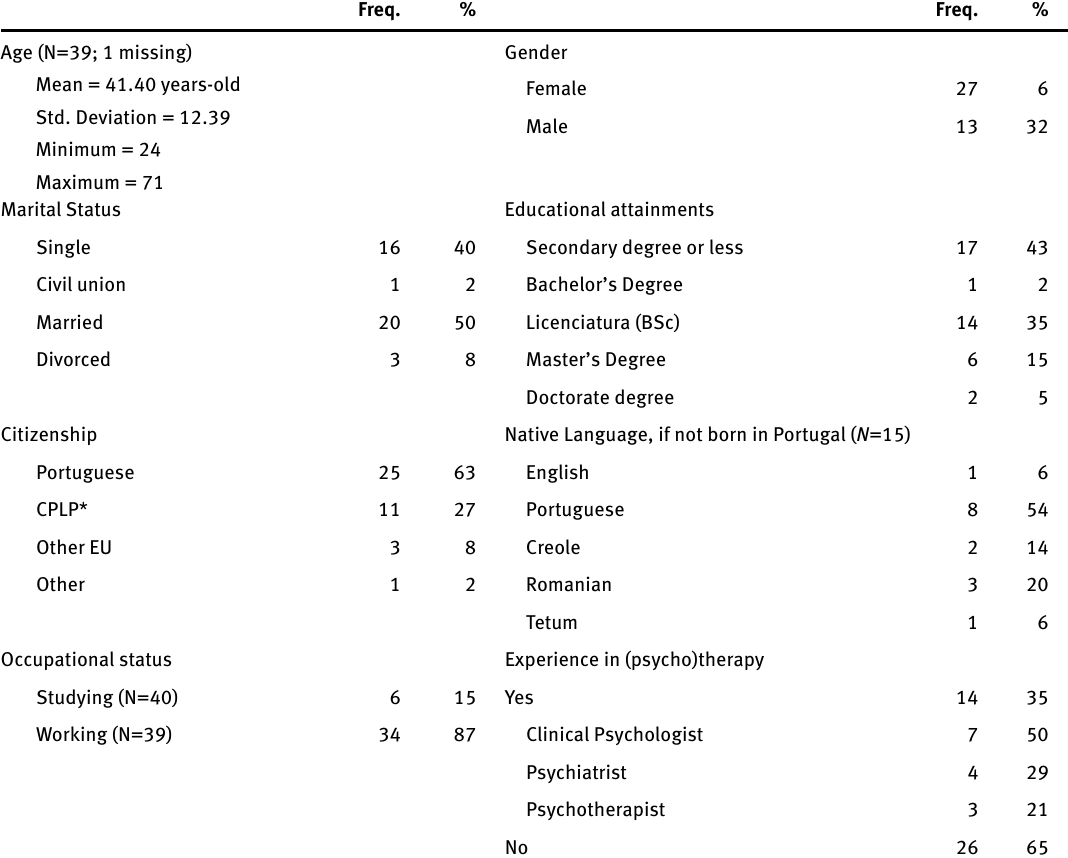
Table 2: Demographic characterisation of the sample (N=40) Freq. % Freq. % Age (N=39; 1 missing)